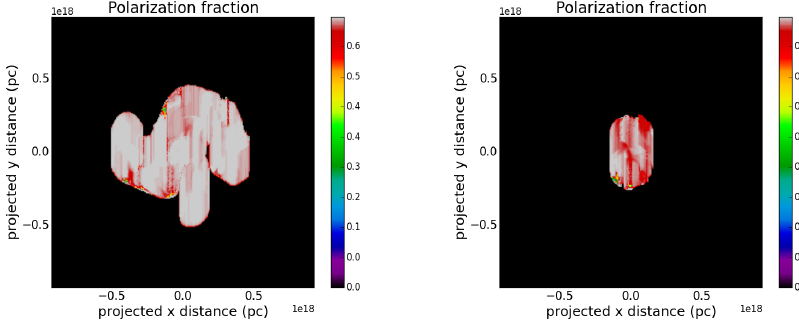
Figure 4. Linear fractional polarization for cases with σ = 10 − 3 ( left ) and σ = 0.1 ( right ), at t =